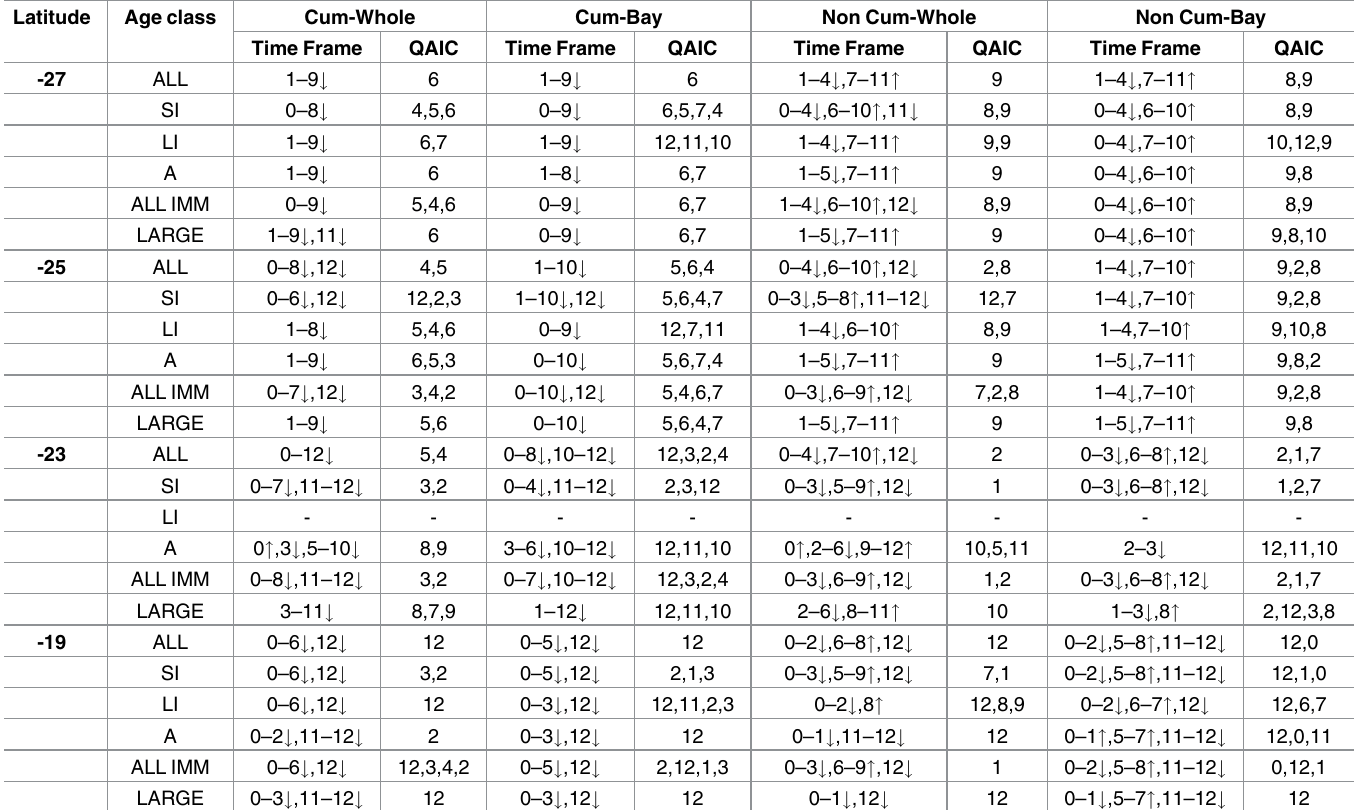
Table 14. Model results for all turtles and monthly mean minimum temperature. " denotesincreasedstrandingsrates with increasedmonthly mean minimum temperature. # denotes decreased stranding rates with increasedmonthly mean minimum temperature. Age class abbreviations: ALL = all turtles, SI = small immature, LI = large immatures, A = adult-sized, ALL IMM = all immature sized animals(small + large), Large = all large turtles (large immatures + adult-sized).The time frame is reportedin monthly ranges where responses were noted. The values reportedin qAIC are the months with the most signifi- cant qAIC